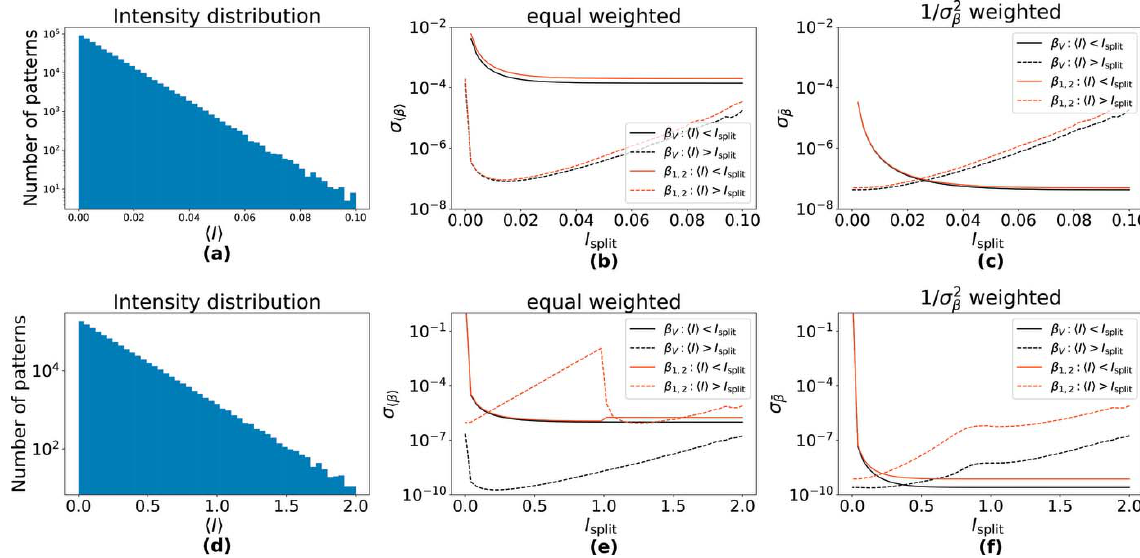
Figure 5 Effects of 1 =(cid:8) 2 -weighting demonstrated on simulated data in which the mean counts per pattern follows exponential distributions with ( a ) mean E ðh I iÞ = (cid:6) 0.01 and ( d ) E ðh I iÞ = 0.2. The data were divided into two parts: one at high intensity with h I i > I split , and its complement with h I i (cid:12) I split . ( b , e ) Standard deviation of the retrieved (cid:6) of the two parts, using equal weighting, as a function of I split . The standard deviation decreases when neglecting the patterns with very low counts as evident in the low-intensity regime of ( b ). The plot of (cid:8) in ( e ) exhibits a sharp discontinuity at I split = 1, which is absent for (cid:8) (cid:6) 1 ; 2 ( c , f ) Standard deviation of the retrieved (cid:6) of the two parts, using 1 =(cid:8) 2 -weighting. In this case the lowest standard deviation is achieved by using all (cid:6) 1 ; 2 patterns to estimate (cid:6) . (cid:6) V always performs better than (cid:6) 1, 2 , especially in the high-intensity regime, see ( f